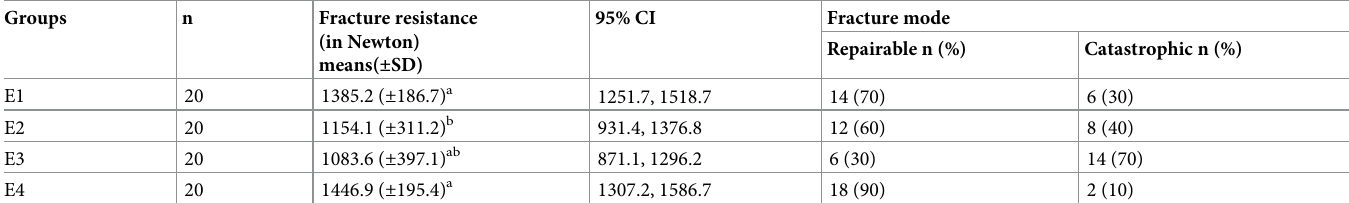
Table 1. Results of fracture resistance and fracture modes.